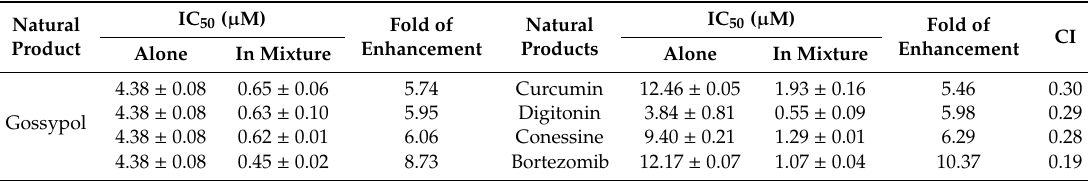
Table 5. Combinatorial e ff ects of gossypol with other natural products in inhibition of infection of ZIKV PRVABC59